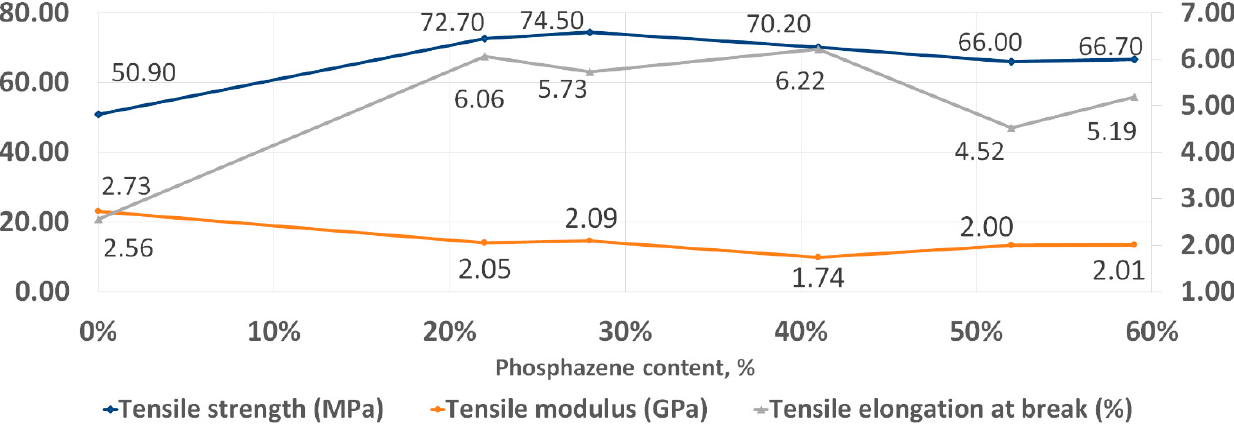
Figure 8. Tensile strength properties of cured resins.